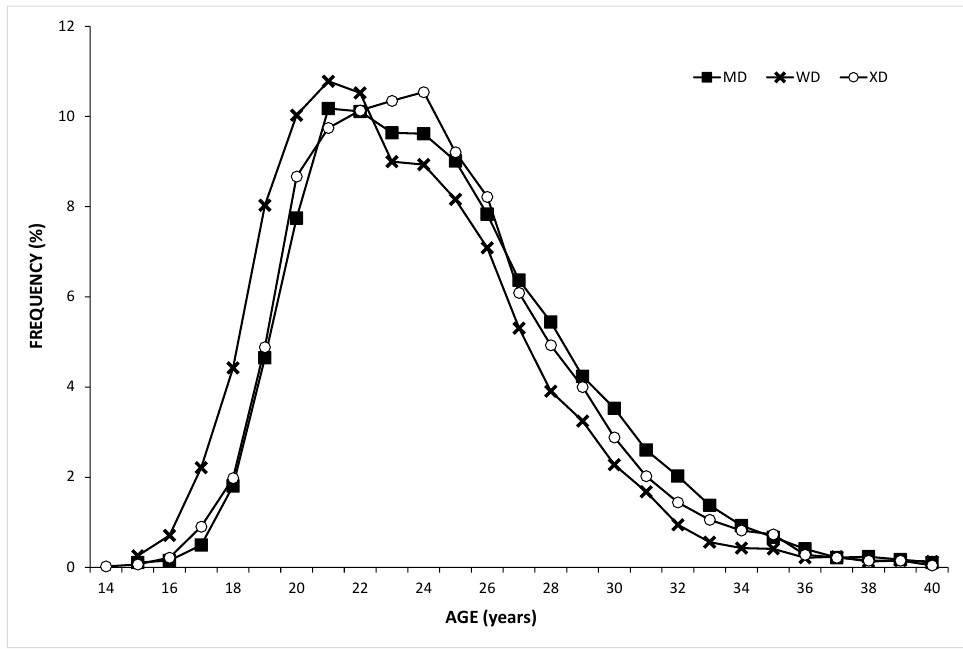
Figure 3. Frequency distribution regarding age in men’s doubles (MD), women’s doubles (WD) and mixed doubles (XD) badminton players at 1-year intervals in the analysed period (1994–2020). Table 1 presents the frequency distribution according to doubles players’ ages in the last decades. Most badminton players, in the three modalities (MD, WD and XD) were in age group increased 2.62% from the 1990s to 2010s. In WD, a 2.18% decrease was found